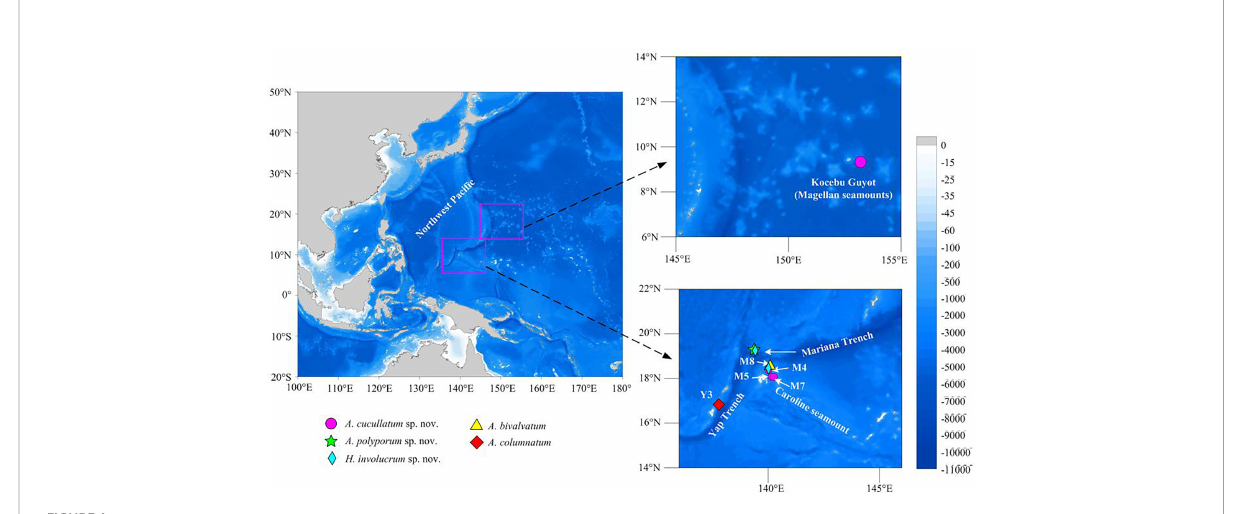
FIGURE 1 Sampling sites in the seamounts of the tropical Western Paci fi c